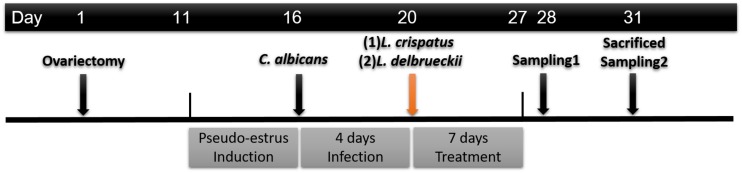
Timeline of the experimental animal treatment and sample collection.